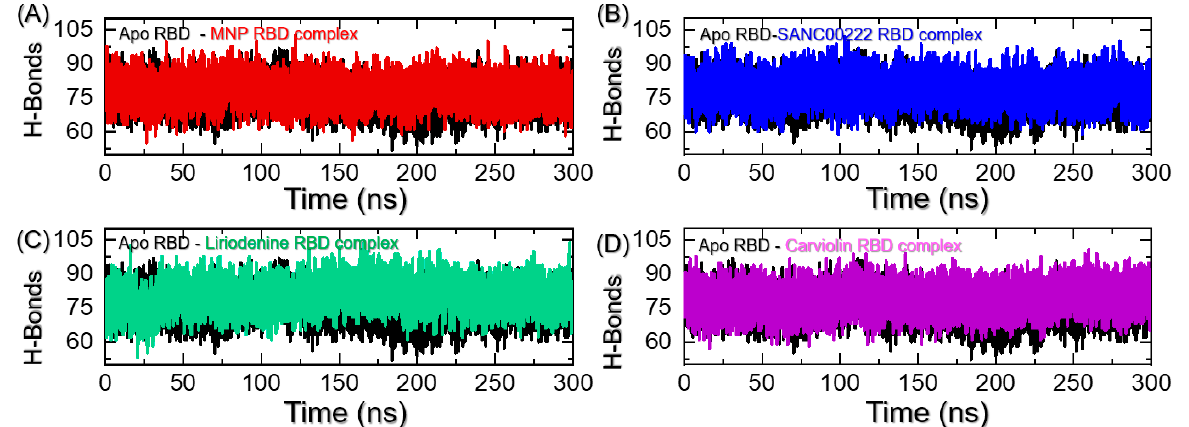
Figure 8. Hydrogen-bonding calculation for each complex during the simulation time. ( A ) shows the H-bonds patterns for apo-RBD and MNP-RBD complex, ( B ) shows the H-bonds patterns for apo-RBD and SANC00222-RBD complex, ( C ) shows the H-bonds graphs for apo-RBD and Liriodenine-RBD complex, while ( D ) represents the H-bonds graphs for apo-RBD and Carviolin-RBD complex over the course of the 300 ns simulation time.